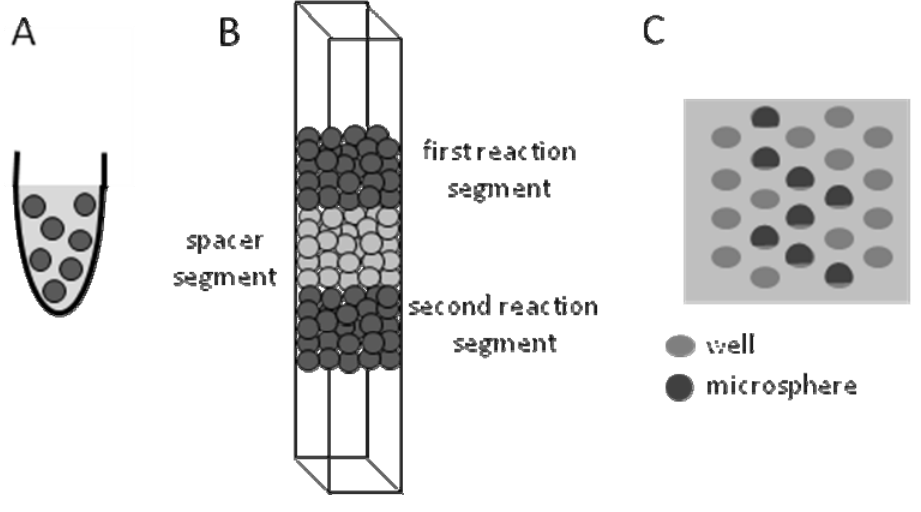
Figure 5. Platforms for using microspheres in biosensing include (A) in suspension in a tube, (B) packed in a channel (2 cm in length, 250 μ m in width, and 60–70 μ m in depth) that contains one or more reaction segments, and (C) within chemically-etched wells on an optical fiber where the microspheres fit into etched wells of nearly matching